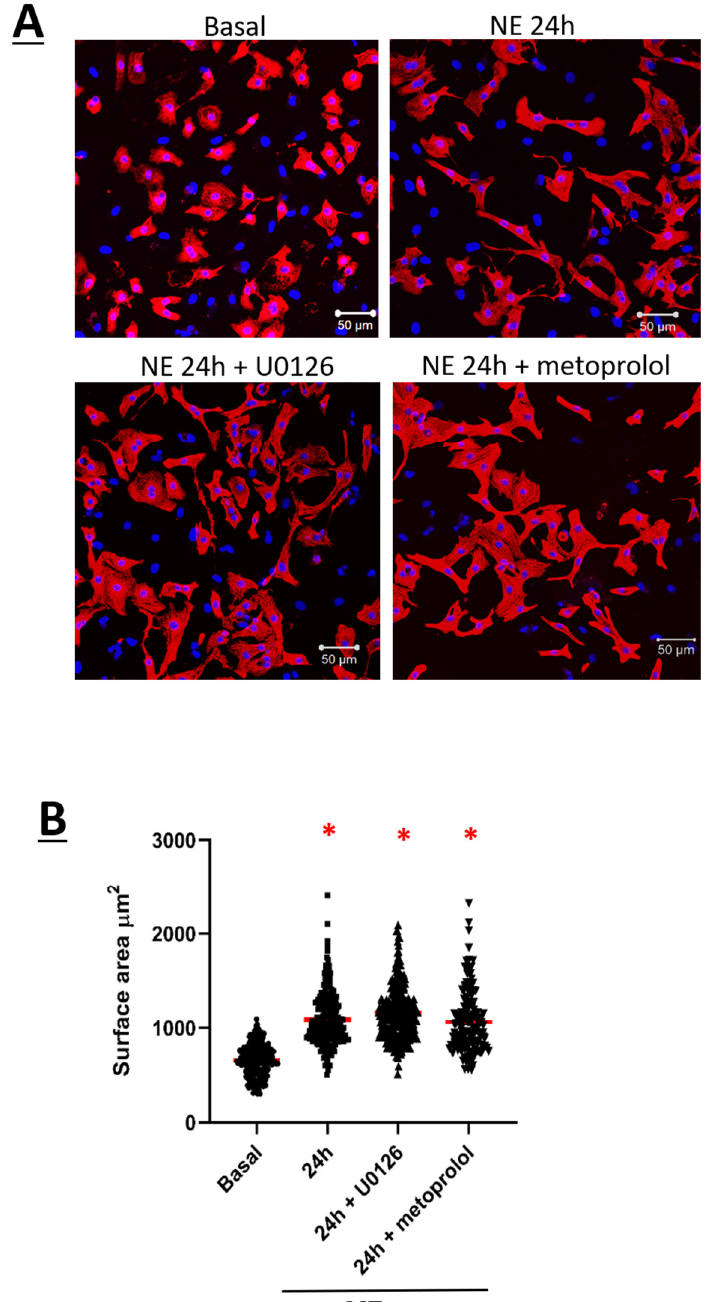
Figure 6. ( A ) Neonatal rat cardiomyocytes in basal condition, treated with NE for 24 h, or pre-treated with either 10 µ M U0126 or metoprolol tartrate ( β 1-blocker) for 1 h followed by treatment with NE for 24 h. Cardiomyocytes were fixed with 2% PAF for 20 min at room temperature. Cardiomyocytes were then permeabilized with 0.2% Triton-X. Primary antibody: mouse anti-Troponin-T was added for 90 min at room temperature followed by overnight incubation at 4 °C. This is followed by incubation of secondary antibody: Goat anti-mouse Alexa 555; and DAPI for 90 min at room temperature in the dark. Images were captured by microscope with 20× objective. Images were analyzed using ZEN software, and the surface area of 250 cells was measured by marking the borders of each cell. Statistical analysis was performed using one-way ANOVA. ( B ) Dot plot showing the surface area of each cardiomyocyte. The red line represents the mean surface area of 250 cells. * p < 0.01 vs. Basal. ( n = 4). Statistical analysis was performed using one-way ANOVA.